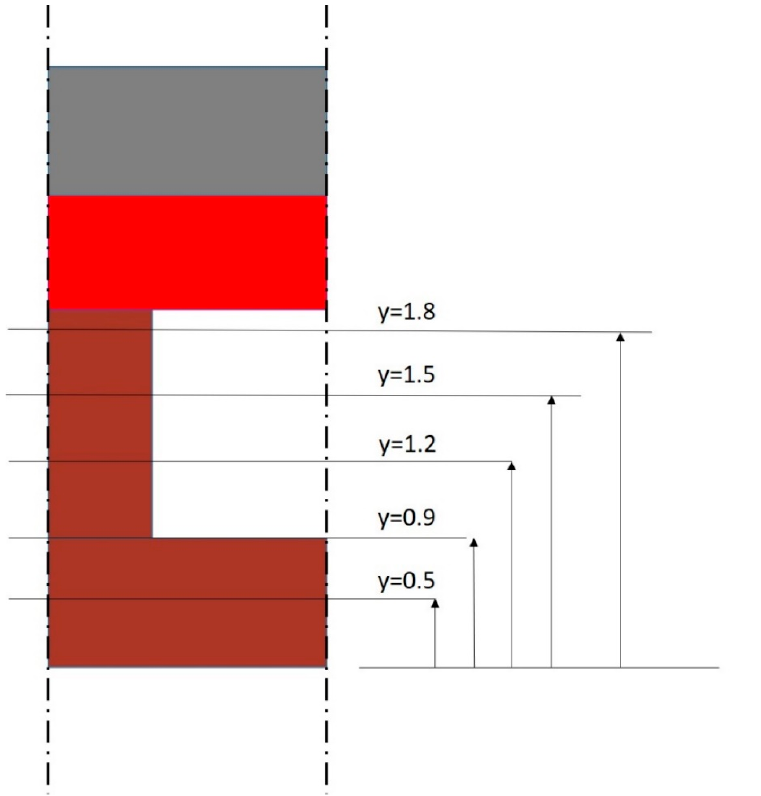
Figure 7. Highlight of different upper boundaries of local models.